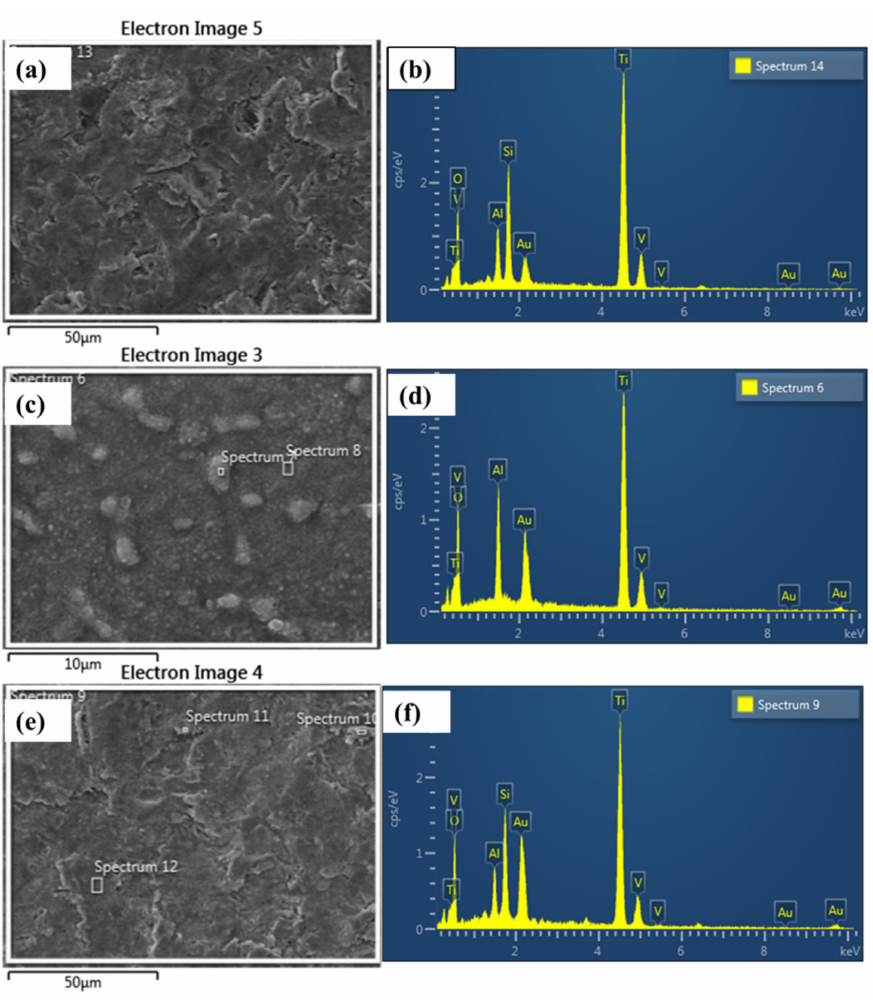
Figure 3. EDX results of Ti64 treated at different conditions; ( a , b ) SB; ( c , d ) MT; ( e , f ) SBT.